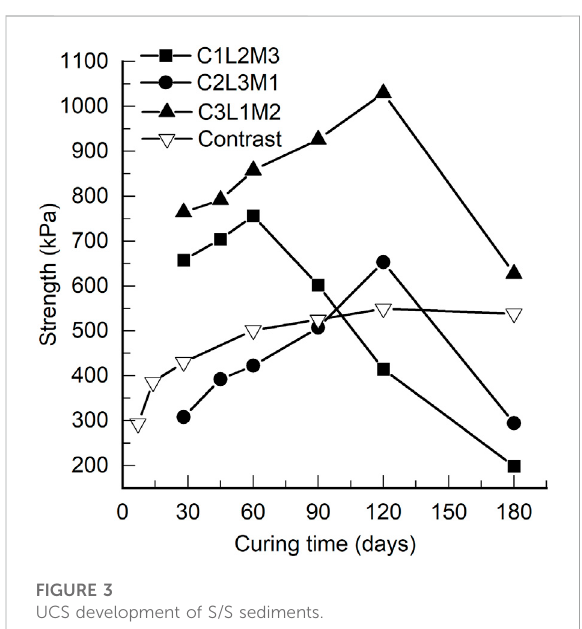
FIGURE 3 UCS development of S/S